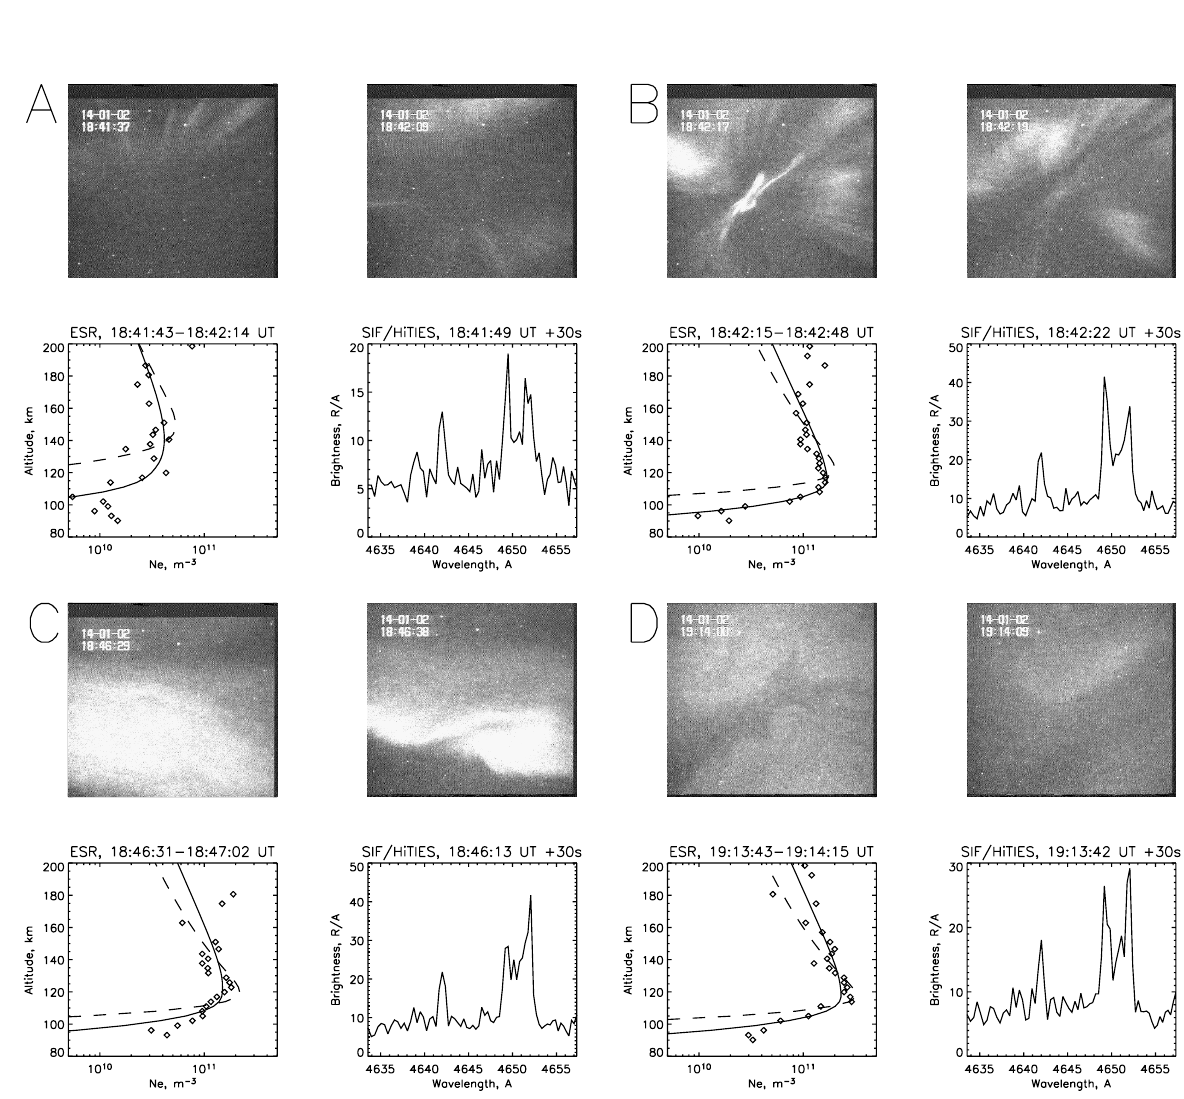
Fig. 11. Snapshots of four intervals on 14 January 2002. For each of the intervals two images from the SIF narrow field imager are given, the ESR electron number density altitude profile, and the HiTIES spectrum of the N + profiles show a fit with the maxwellian precipitation, and dashed lines – monoenergetic precipitation. See